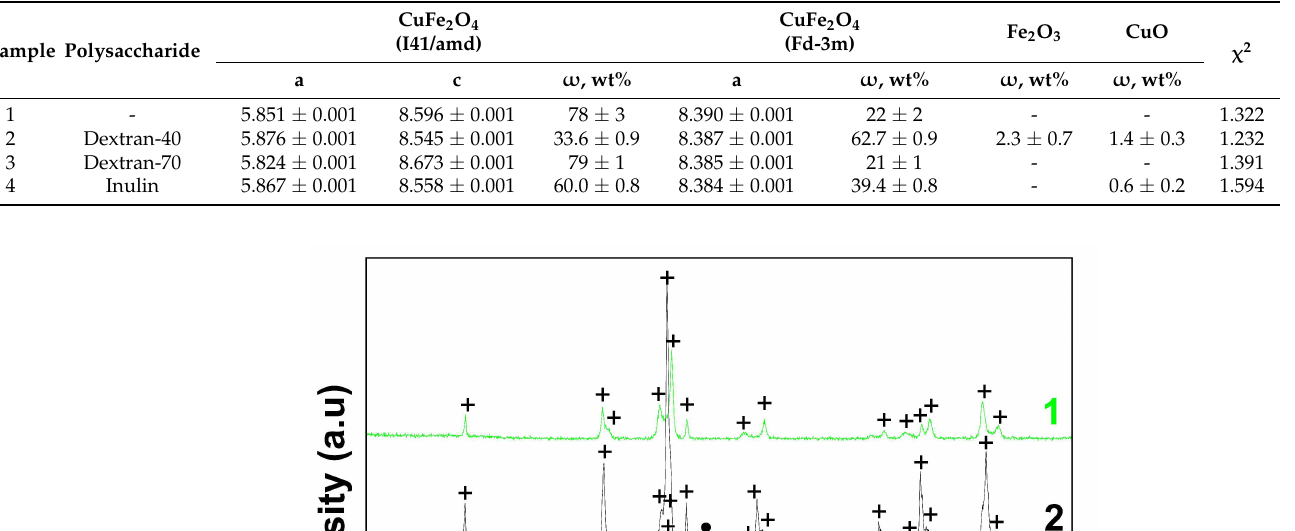
Table 2. Cell parameters and phase composition of the samples obtained by ion-exchange resin precipitation and annealed at 800 °C for 1 h.